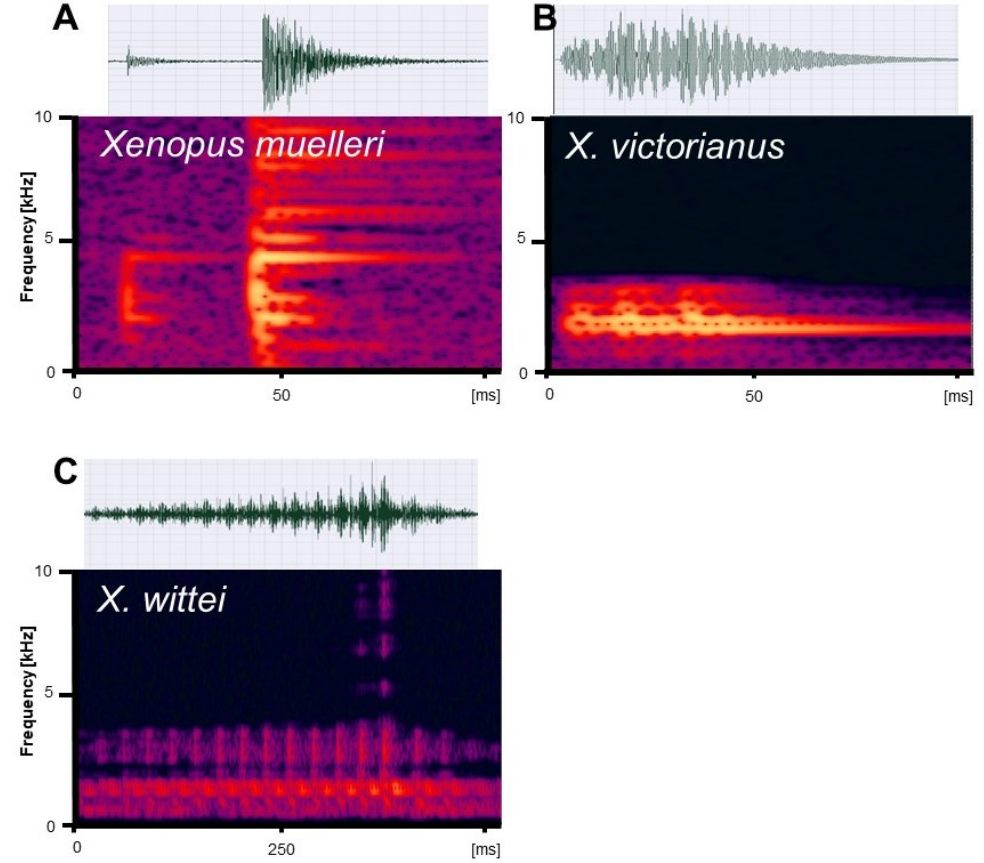
Figure 13. Advertisement calls of Pipidae in Rwanda. ( A ) Xenopus muelleri, ( B ) Xenopus victorianus , and ( C ) Xenopus wittei (call recordings by Ref. [68]). Calls are shown as representative spectrograms and